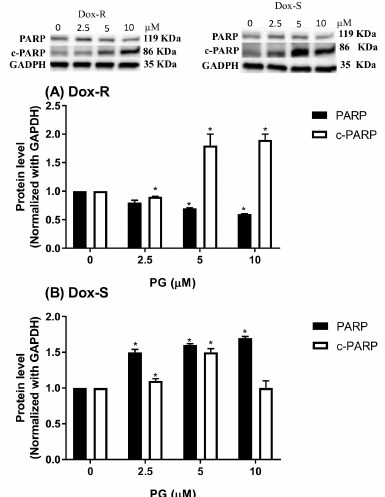
Figure 4. Expression of poly ADP ribose polymerase (PARP) levels in (A) Dox-R and (B) Dox-S cells after PG treatment. Non-cleaved PARP (PARP) and cleaved-PARP (c-PARP) levels after PG treating were measured by Western blotting and all chemiluminescent intensity were normalized with GAPDH. Results were shown as mean ± SD with 3 independent experiment. *, p < 0.05 compared with untreated